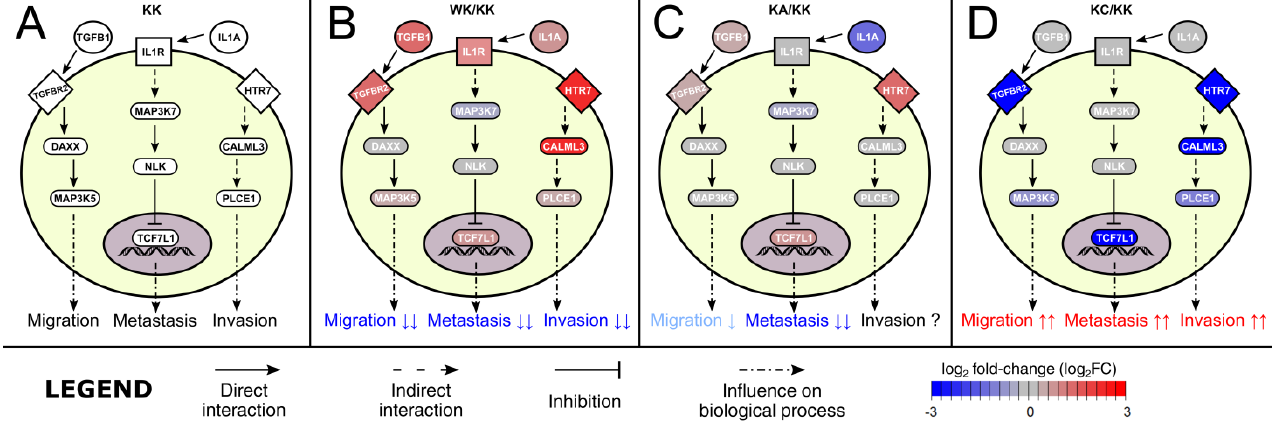
Figure 8. The most relevant similarities and differences in signaling by WWOX, AP- 2α and AP - 2γ. ( A ) KK variant. ( B ) WK/KK comparison. ( C ) KA/KK comparison. ( D ) KC/KK comparison. FGFR3 , STAT6 , EFNA1 , GSK3B , PIK3CB , SOS1 and KIF7 were chosen as